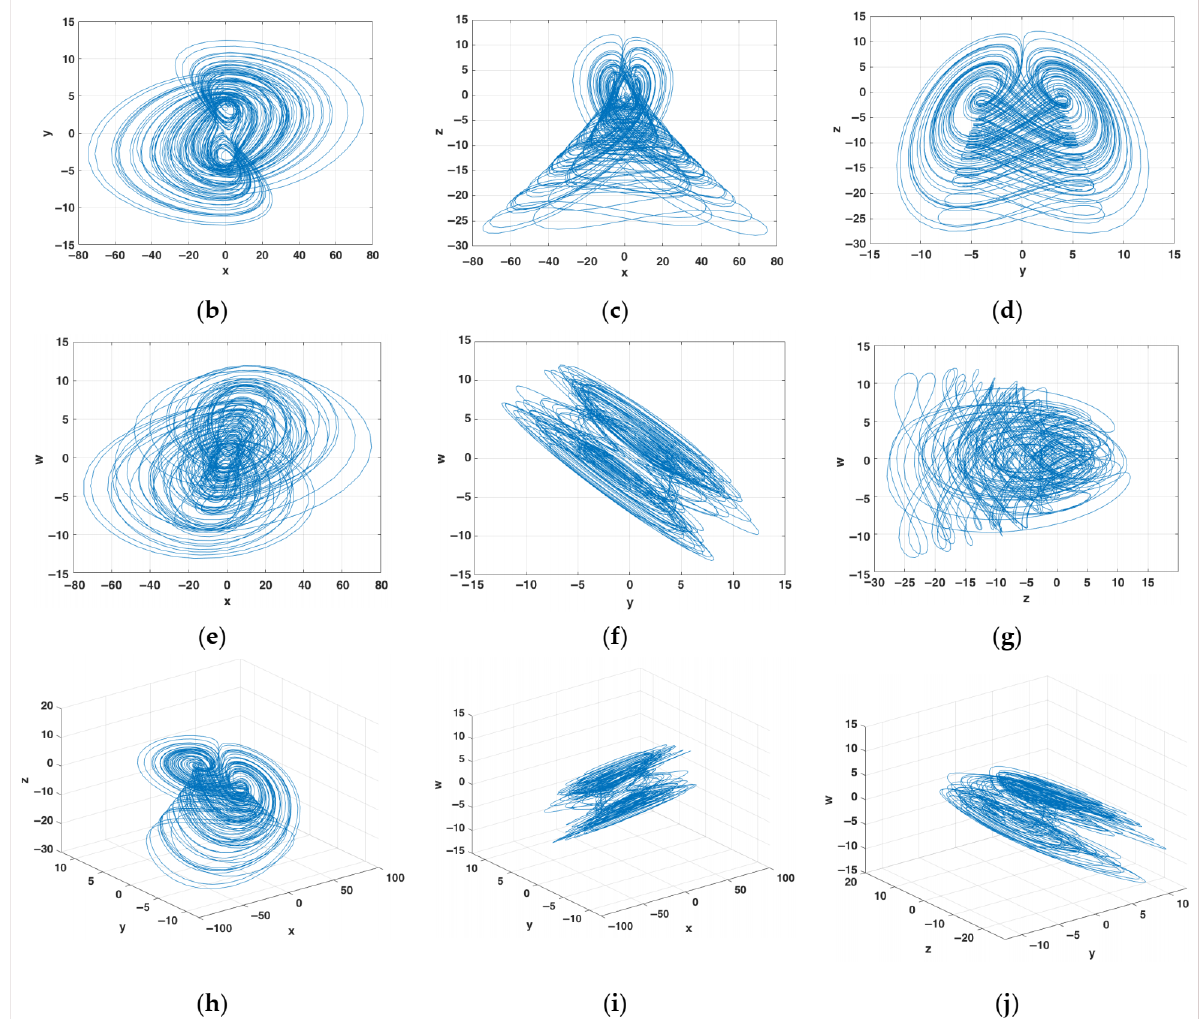
Figure 3. Hyperchaotic attractor of system (1): ( a ) time evolution of states x , y , z and w ; ( b ) phase plane x versus y ; ( c ) phase plane x versus z ; ( d ) phase plane y versus z ; ( e ) phase plane x versus w ; ( f ) phase plane y versus w ; ( g ) phase plane z versus w ; ( h ) phase space x versus y versus z ; ( i ) phase space x versus y versus w ; and ( j ) phase space y versus z versus w